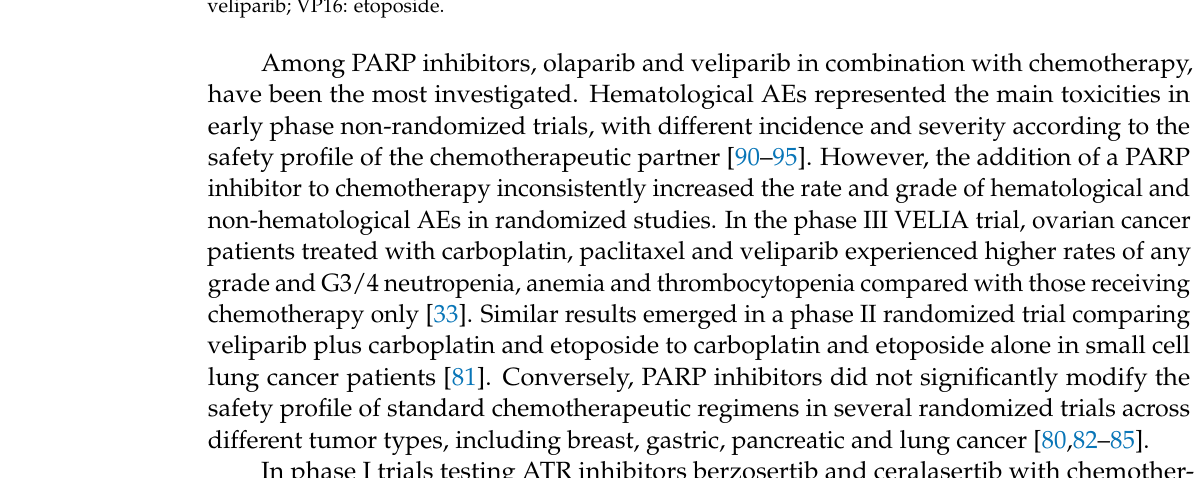
* Two-arm non-comparative trial. Table Legend: ∆ differential incidence between experimental and control arm; Ada: adavosertib; Berzo: berzosertib; Beva: bevacizumab; CBDCA: carboplatin; CDDP: cisplatin; Cedi: